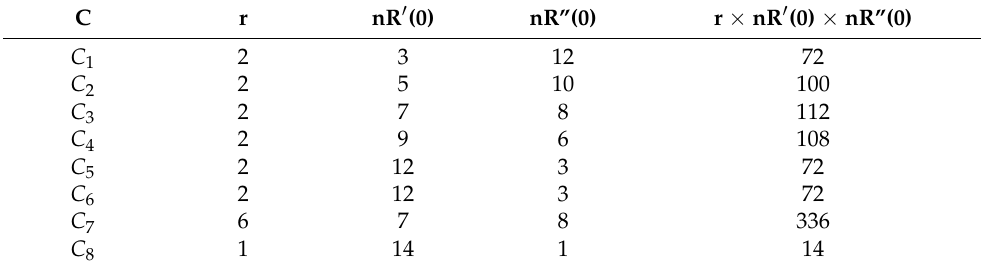
Table 3. Steps taken for calculating the Szeged index Sz ( R ) for the RNA structure depicted in Figure 2. The sequence and secondary structure representation in dot-bracket notation appear below the